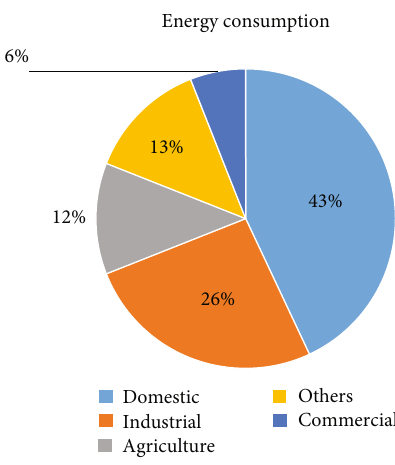
Figure 2: Energy consumption in Pakistan